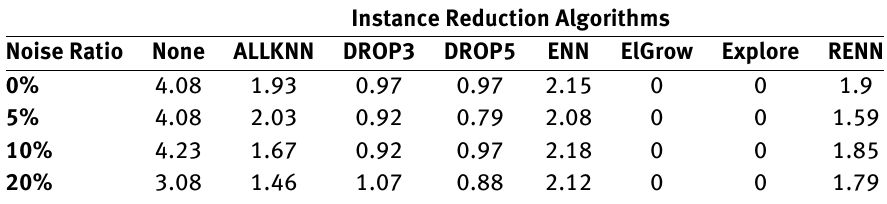
Table 16: Average Tree Size for pruned trees at different noise ratios